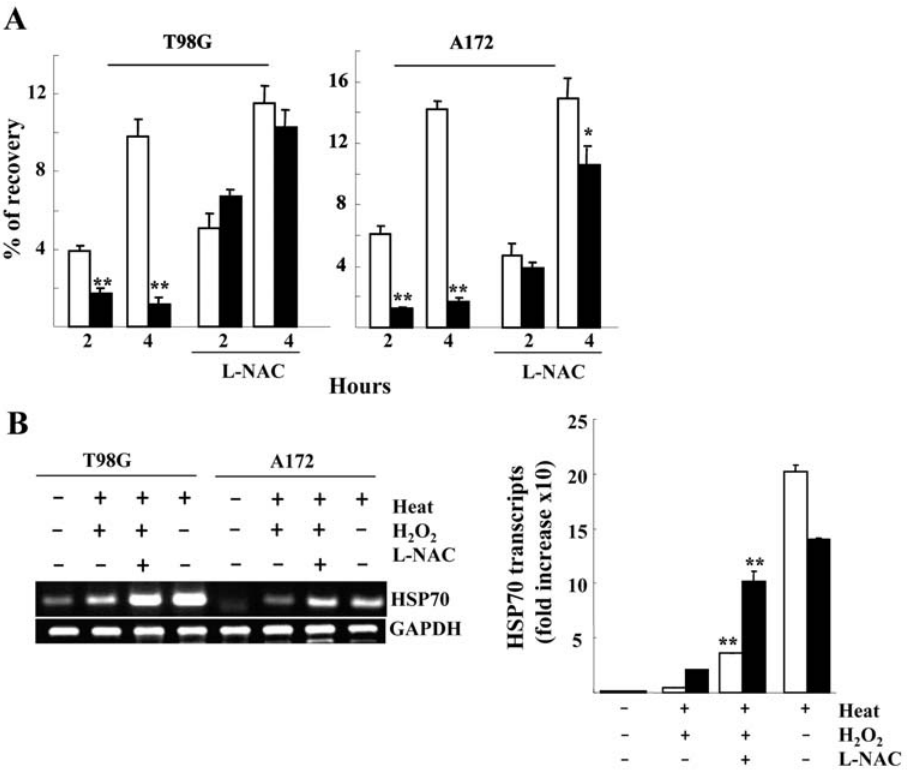
Figure 5. Recovery of protein folding activity. A ) Refolding activity. Cells were transiently co-transfected with the pGRE/RL-TK reporter genes, treated with 5 mM dexamethazone for 10-12 h, exposed to heat (44 u c for 20 min) with (closed) or without (open bars) 0.25 mM H 2 O 2 pretreatment, incubated for 2 to 4 h and luciferase activity was measured. Cells were also incubated with 5 mM L-NAC for 30 min prior to 0.25 mM H 2 O 2 pretreatment. *, P , 0.05, **, P , 0.01 compared with H 2 O 2 -untreated cells. B ) HSP70 transcripts. Total RNA was harvested from cells treated as indicated and HSP70 transcripts were evaluated by RT-PCR (left). HSP70 transcripts were determined by real-time PCR and normalized to GAPDH levels (right panel). **, P , 0.01 compared with heat/H 2 O 2 -treated cells. Columns display the mean 6 S.D. of data from three separate